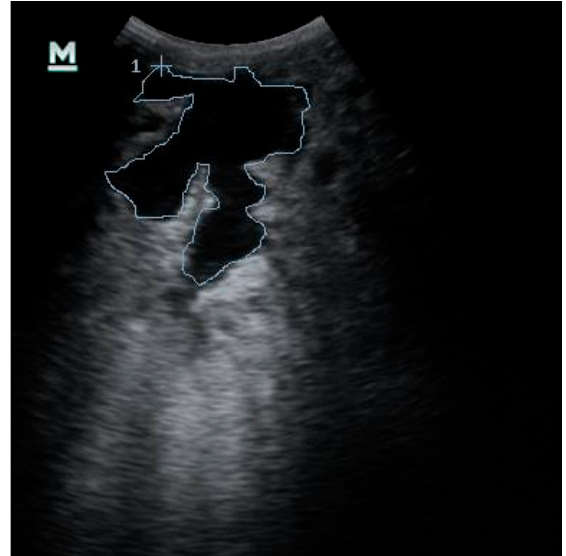
Figure 1. Ultrasonographic evaluation of the udder cistern size of the fore quarter in cross-section performed at T1. Freehand tracing of the udder cistern to calculate the udder cistern size using ImageJ software (National Institute of Health, Bethesda, MD, USA).